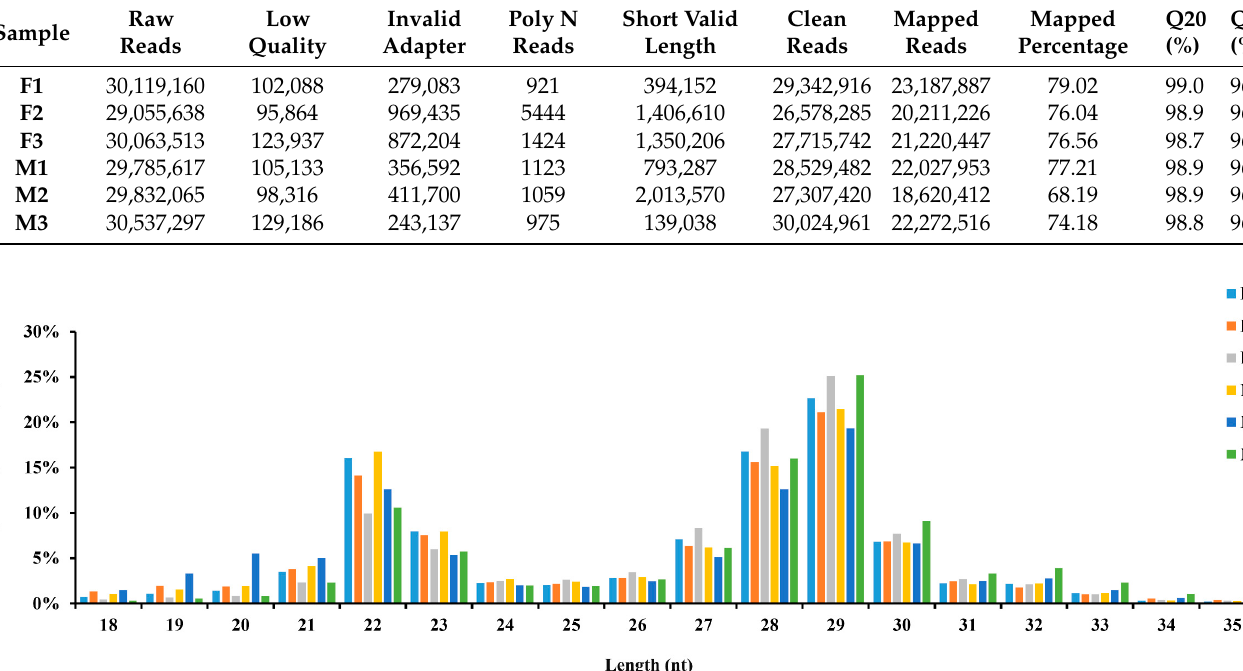
Table 1. Overview of the small RNA sequencing data.